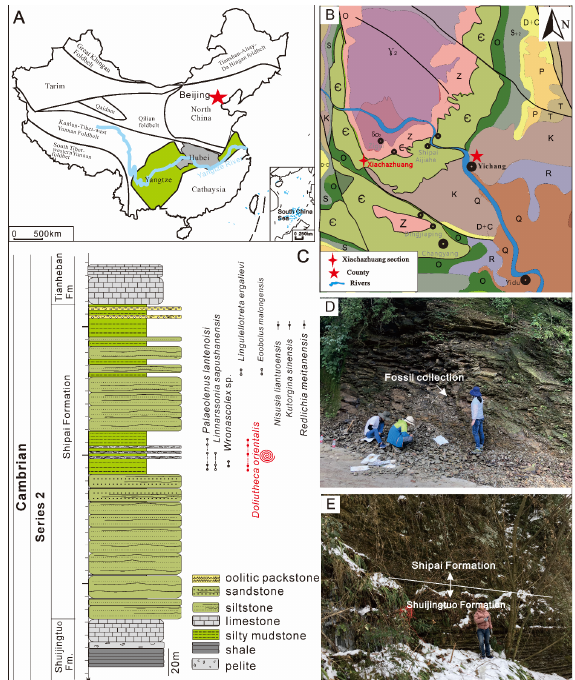
Figure 1. Simplified geological map, paleogeography, fossil localities and early Cambrian stratigra- phy of the Three Gorges area. ( A ) Generalized map showing the principal continental blocks of China. ( B ) Geological map notes the localities of the Xiachazhuang section in the Yangtze Gorges region. ( C ) Stratigraphic column with the early records of fossil biozones from the Shipai Formation of the Xiachazhuang section, noting the levels where hyoliths illustrated in this paper were recov- ered (marked by the arrow). ( D ) Field photo of the Shipai Formation of the Xiachazhuang section, which yielded abundant hyoliths and other fossils including brachiopods, trilobite, etc. ( E ) Field photo showing the boundary between the Shuijingtuo Formation and the upper Shipai Formation.